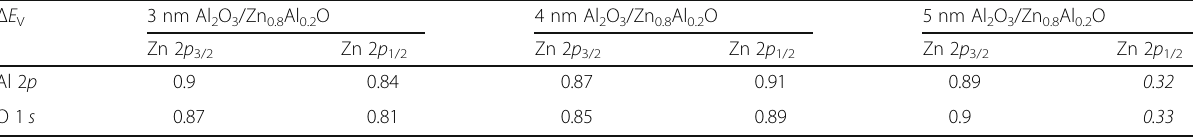
Table 3 The Δ E V values of the Al 2 O 3 /Zn 0.8 Al 0.2 O heterojunction with Al 2 O 3 thickness of 3 – 5